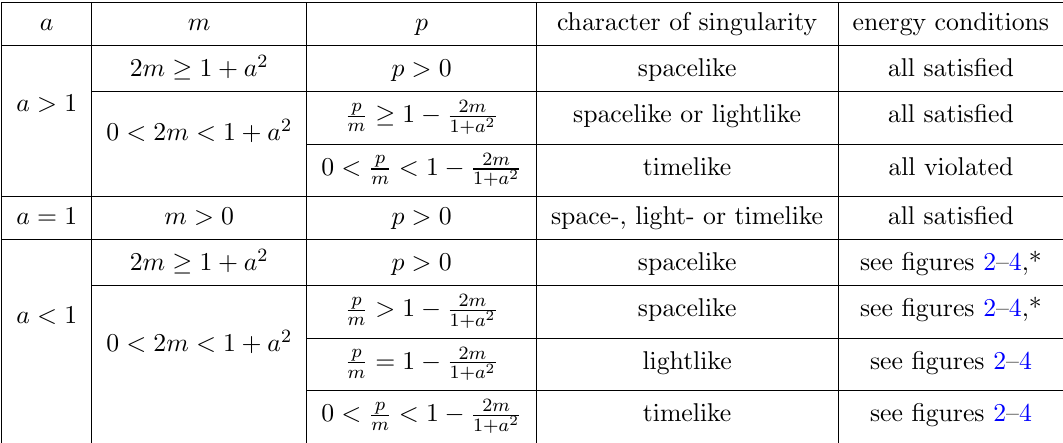
Table 1 . Classi(cid:12)cation of the parameter space ( a; m; p ) according to the character of singular surface and to the energy conditions. The cases marked with * indicate that the DEC is necessarily